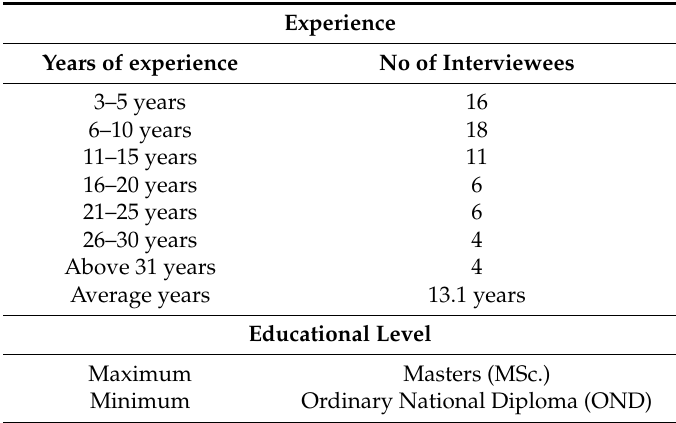
Table 4. Interviewees’